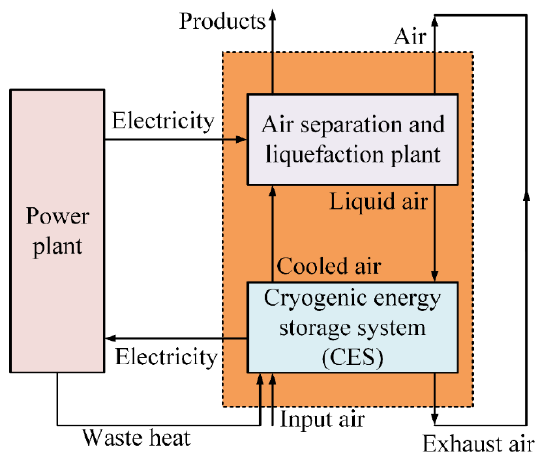
Figure 12. Schematic diagram of cryogenic energy storage (CES), which is a special type of low-temperature thermal energy storage (TES) where a cryogen, such as liquid air or liquid nitrogen, is produced during off-peak hours and used during peak hours [37].